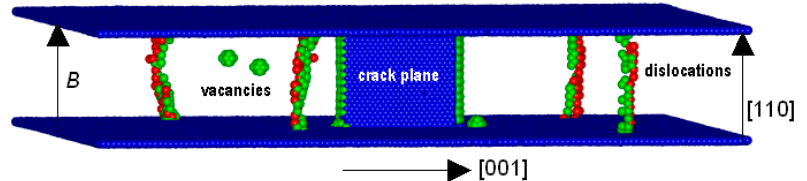
Figure 3. Temperature 300 K, biaxiality ratio α = 0.1; generation of vacancies and a 3D visualization of the emitted dislocations. Four dislocations are emitted. The red-green dislocation cores are visualized like in [6], the blue color represents the surface atoms, including the ( 110 ) crack plane. The isolated clusters of green atoms indicate the